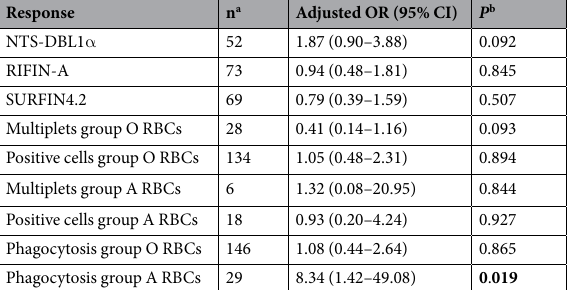
Table 2. Association of the measured variables with malaria clinical outcome. a Number of responders. b Each response was tested for association with severe malaria in a multiple logistic regression adjusted for hemoglobin level, axillary temperature, and fever at admission. Malaria clinical presentation (Mild and Complicated) was the dependent variable while each of the measured responses were the independent variables. Boldface type indicates statistical